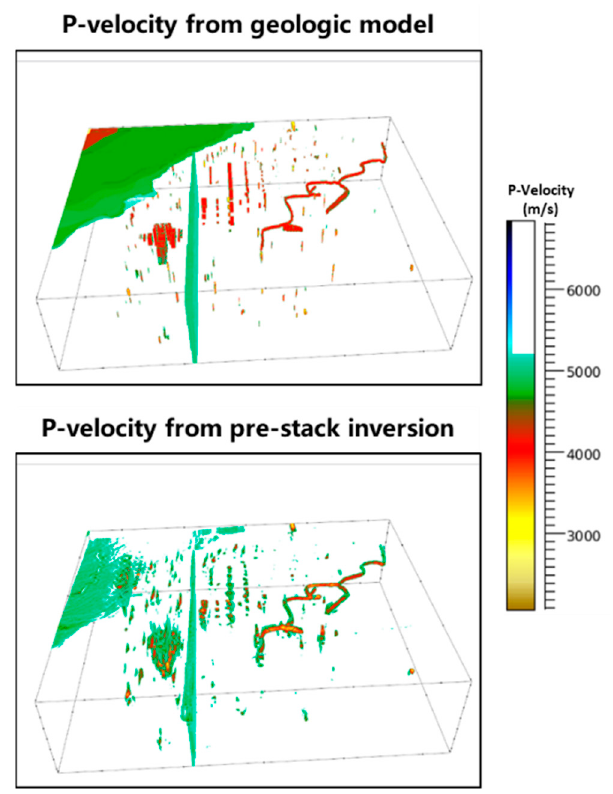
Figure 5. Comparison of P wave velocity of the geological model and that of the pre-stack inversion. The upper picture is the P wave velocity from the geological model; the lower picture is the P wave velocity from the pre-stack inversion. Table 2. P wave velocity errors between the P wave velocity of the geological model and that of the pre-stack inversion.